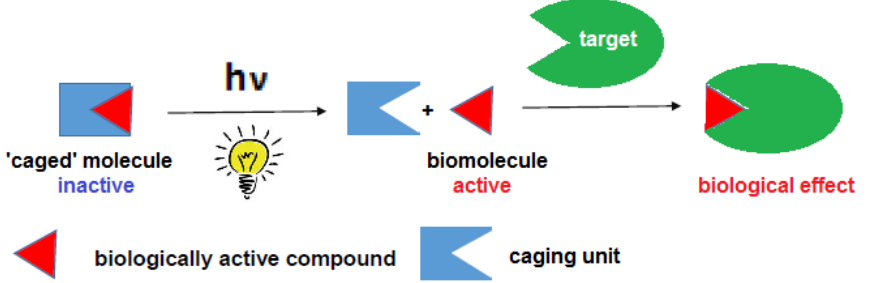
Figure 1. A simplified overview of the operation of PPGs for the release of biologically active substrates (adapted from Korzycka et al. [8] and Piant et al. [9]).